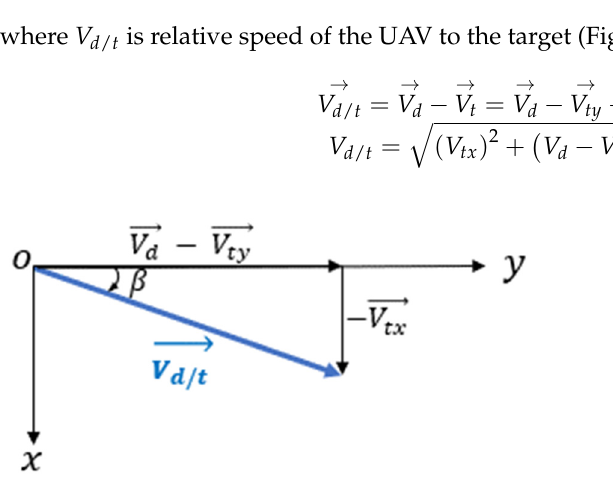
Figure 14. Relative speed of UAV to target.